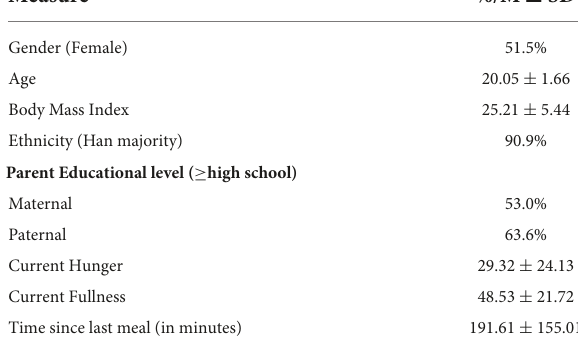
TABLE 1 Demographic and background characteristics of sample ( N =